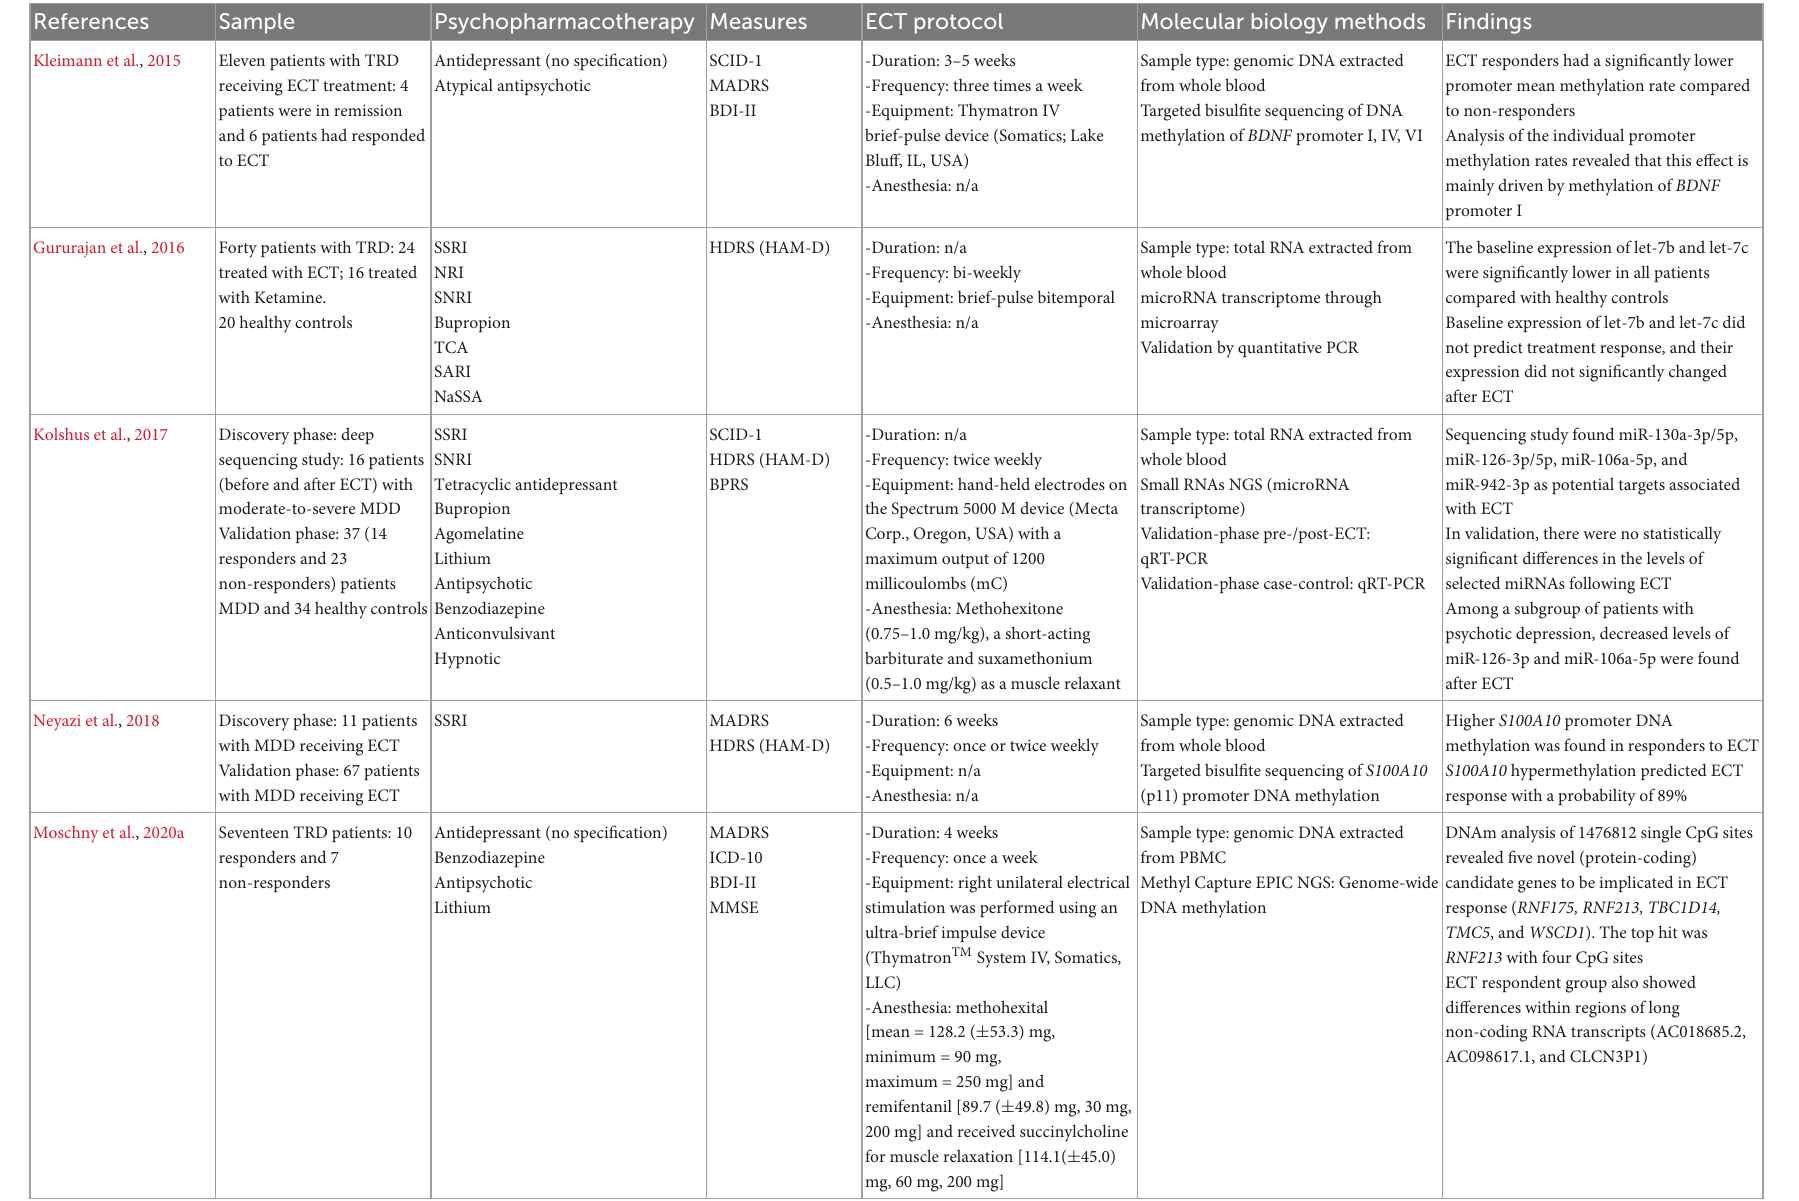
TABLE 1 Study design and epigenetic